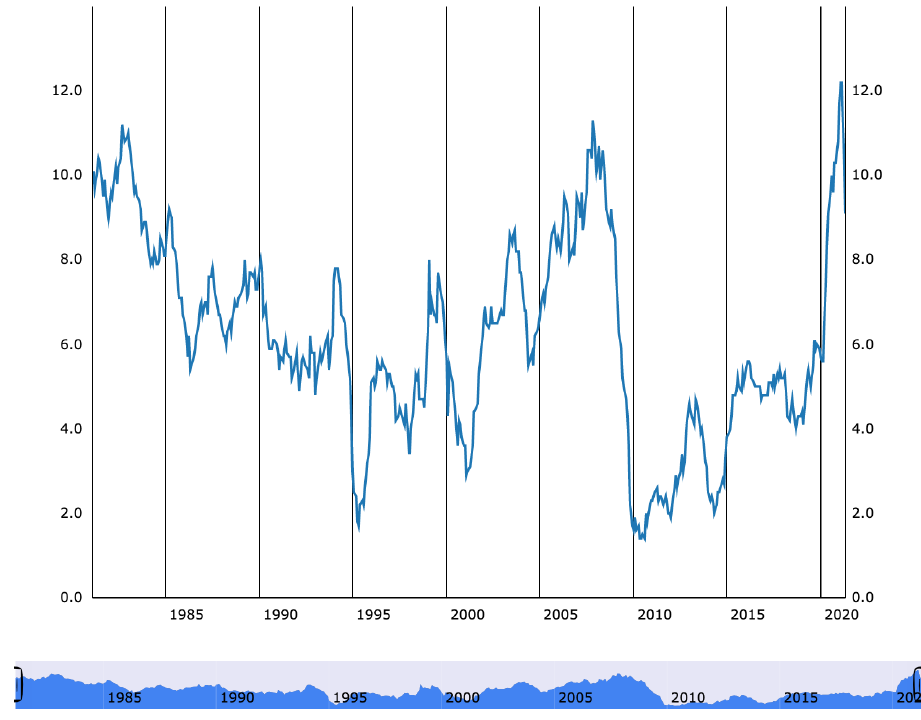
Figure 2. M2 growth